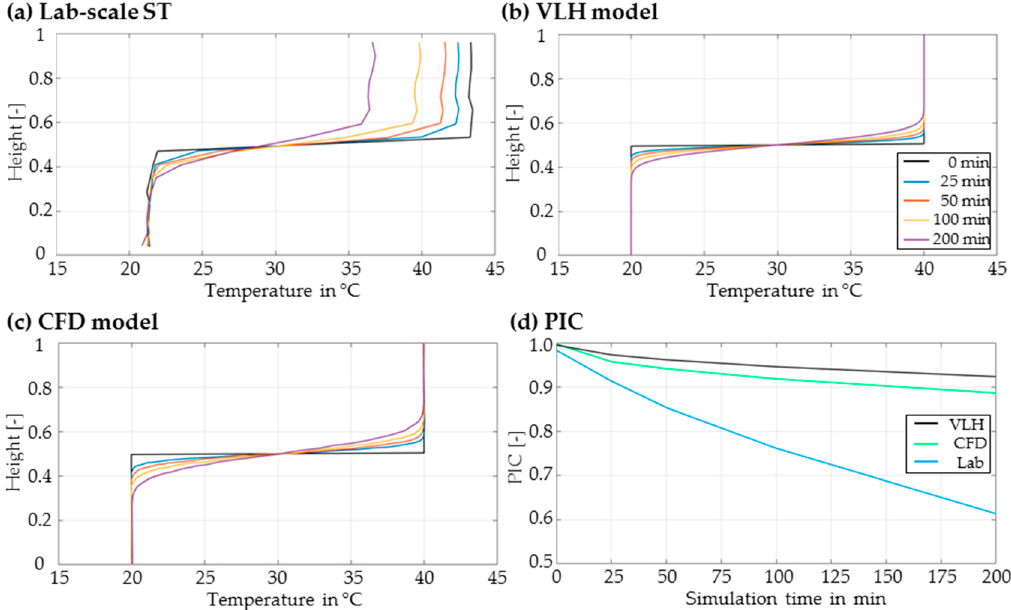
Figure 11. Thermocline Movement for a targeted tank charging sequence in comparison to the ideal position for the ( a ) lab, ( b ) VLH model and ( c ) CFD model, compared based on the ( d ) PIC value.